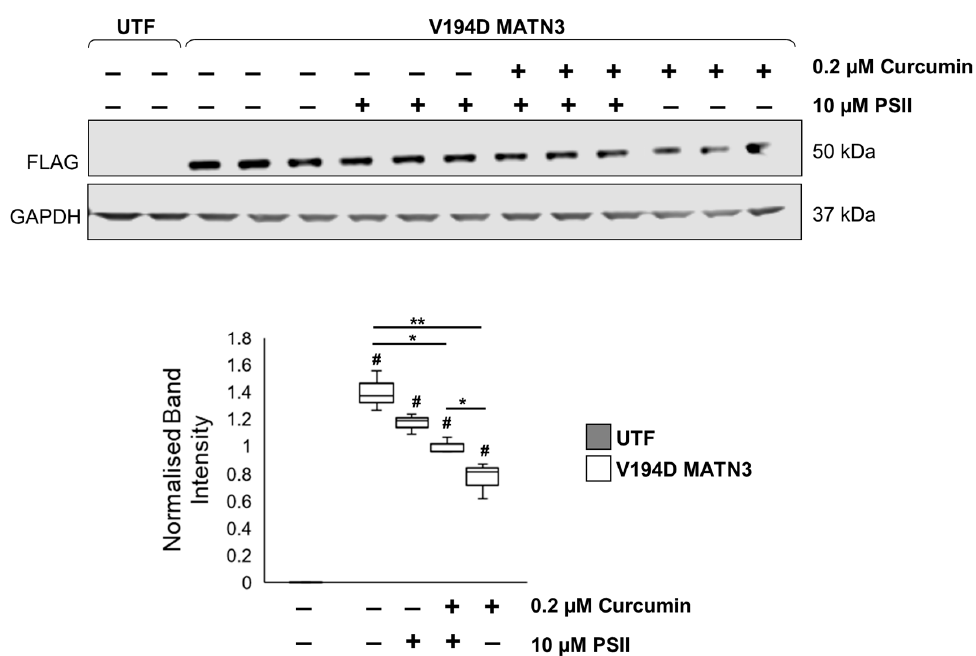
Figure 7. Curcumin promotes proteasomal degradation of V194D mutant matrilin-3 in a cell model of EDM5. V194D mutant MATN3-expressing HELA cells were cultured in the presence/absence of 0.2 µM curcumin for 48 h. To study if curcumin promotes the proteasomal degradation of mutant matrilin-3, the proteasomal inhibitor PSII is added to block the actions of the proteasome. After 48 h, the intracellular expression of FLAG-tagged matrilin-3 was analysed by Western blotting. Curcumin treatment significantly reduces the accumulation of intracellular mutant matrilin-3. PSII administration blocks the effects of curcumin and results in an upregulation in the intracellular expression of mutant matrilin-3 to levels comparable to untreated cells, confirming that curcumin promotes the proteolysis of mutant matrilin-3 by the proteasome. (Equal loading shown by GAPDH. FLAG: FLAG-tagged matrilin-3, GAPDH: glyceraldehyde-3-phosphate dehydrogenase, MATN3: matrilin-3, PSII: proteasome inhibitor II, WT: wild-type, UTF: untransfected, # significant